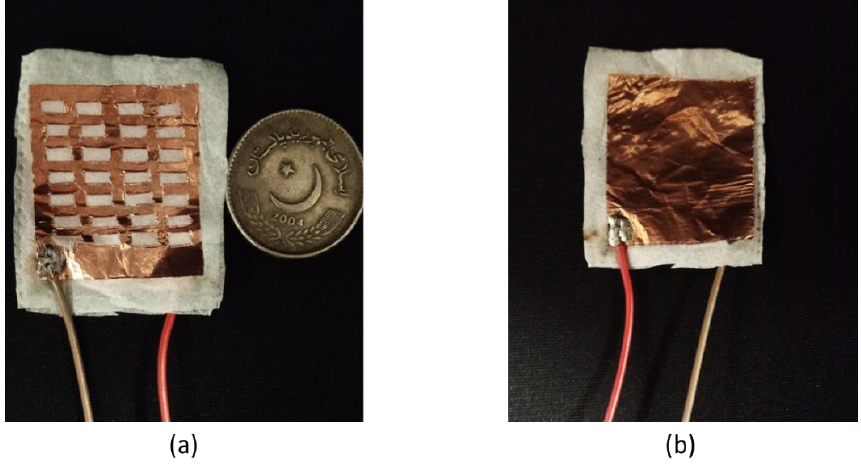
Figure 2. Fabricated parallel-plate sensor: ( a ) Front view of the sensor; ( b ) Back view of the sensor.